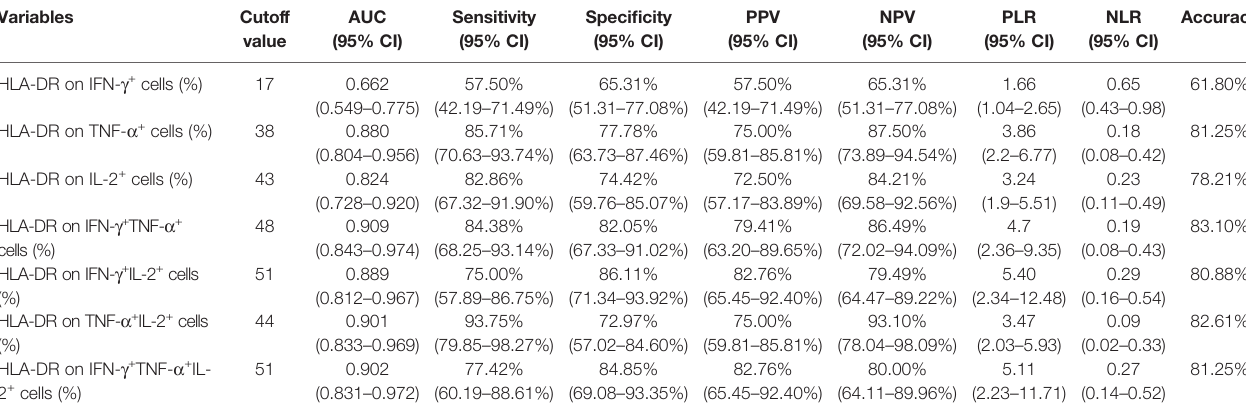
TABLE 2 | The performance of HLA-DR on MTB-speci fi c cells for distinguishing between ATB and LTBI in Qiaokou cohort.